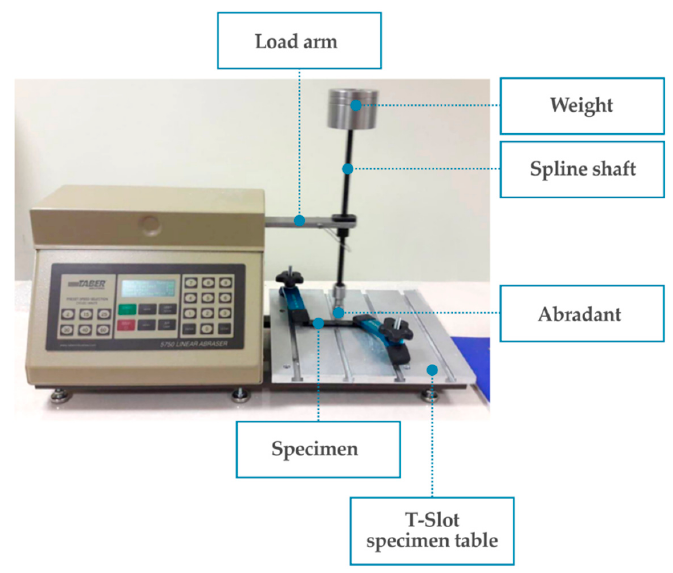
Figure 2. TABER linear abraser model 5750 during the abrasion test.